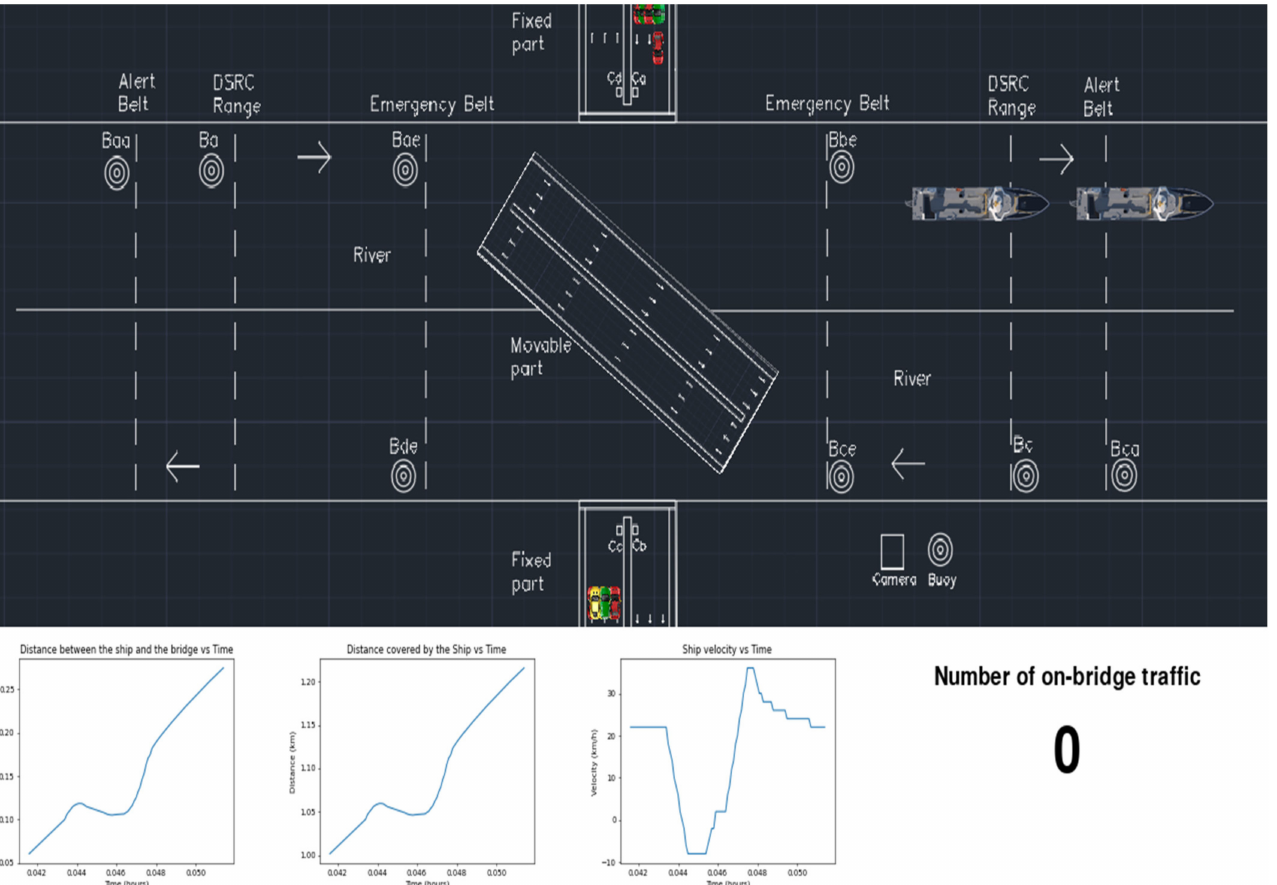
Figure 11. Adaptive Cruise Control among ships in phase two. The forward ship (green) accelerates greatly, and the rearward ship attempts to match